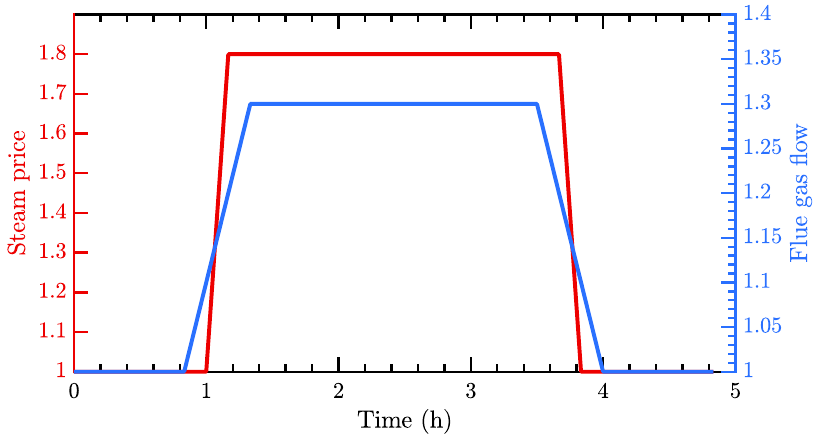
Figure 3. Scaled hourly changes in steam price (Nominal value: $0.01/kg) and flue gas flow rate (Nominal value: 0.0832 m 3 /s). Price (red), Flue gas flow (blue).